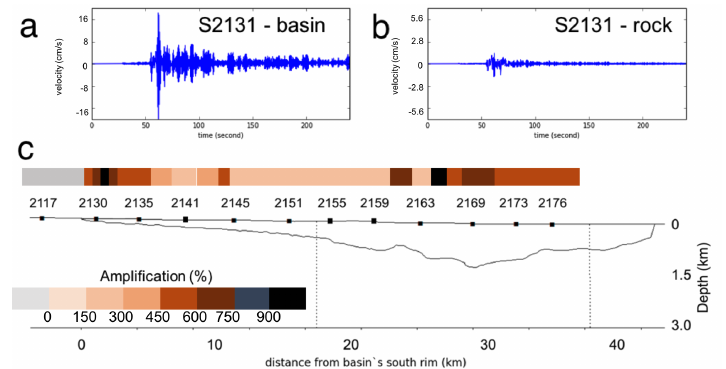
Figure 15. Similar to Figures 13 and 14, but for medium-depth intraslab earthquake scenario. Figure ( a , b ) are basin and bedrock seismograms (at S2131, located about 500 m north of S2130) and Figure ( c ) shows PGV amplification along the S-N cross-section.